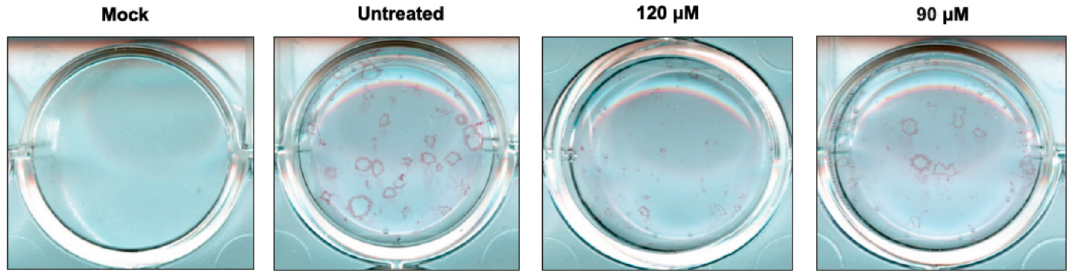
Figure 3. Dose-dependent reduction of influenza A viral plaque formation after treatment with compound 2 . MDCK cells were infected with influenza virus A/ostrich/Denmark/725/96 (H5N2) or mock infected. At 1 h p.i., the virus was removed and the cells were incubated with overlay medium containing compound 2 . 3 days p.i., cells were fixed and influenza A virus plaques were detected by immunostaining with specific, monoclonal anti-M1 antibody.